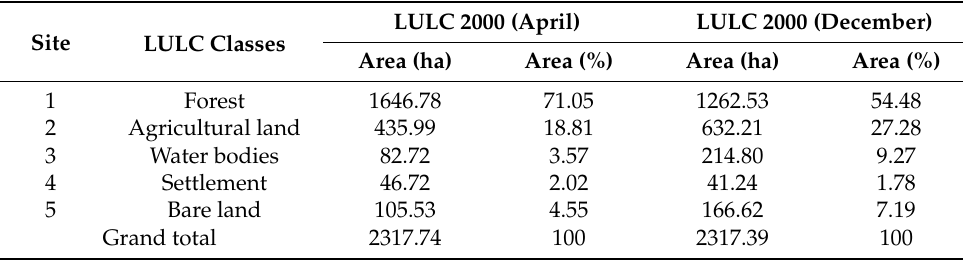
Table 1. The change in land use and land cover (LULC) in Ghodaghodi Lake Complex, Nepal, between April and December